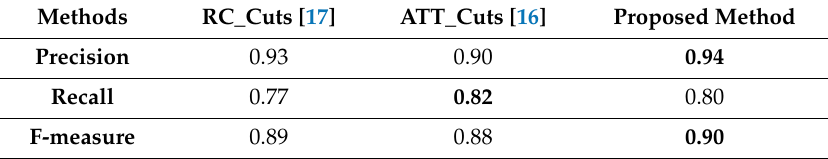
Table 2. Subjective evaluation of the proposed and other methods.